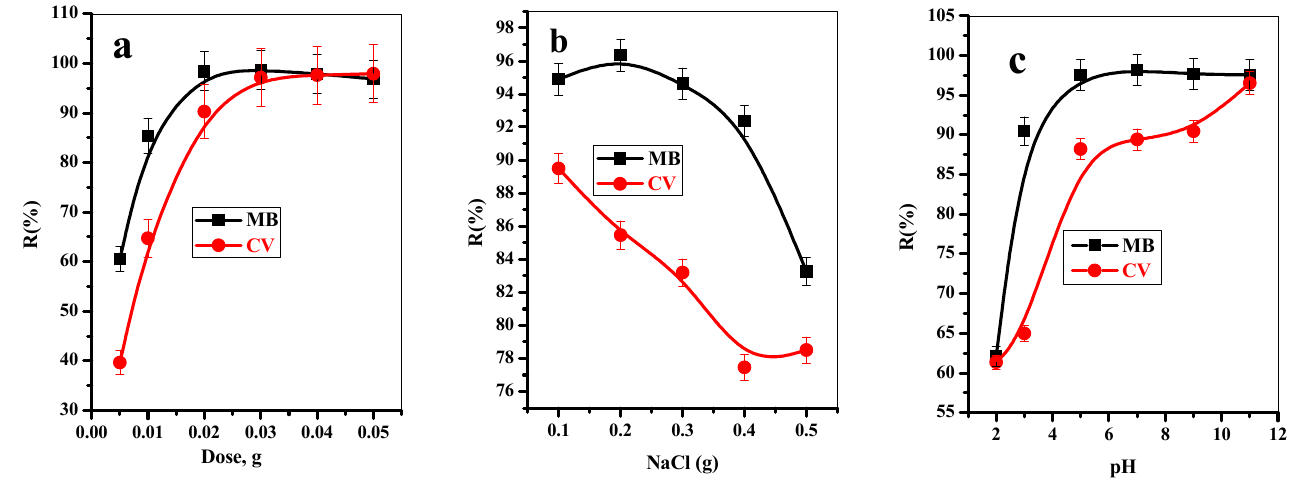
Figure 5. Effect of ( a ) adsorbent dose (t = 8 min for MB and 10 min for CV, [dye] = 30 mg/L, dose = 5, 10, 20, 30, 40, 50 mg, pH = 7, T = 25 ◦ C), ( b ) NaCl dose (t = 8 min for MB and 10 min for CV, (dye) = 30 mg/L, dose = 20 mg, pH = 7, T = 25 ◦ C, NaCL = 100–500 mg), and ( c ) pH on the removal percent of MB and CV-dyes from aqueous solution onto T-BC (t = 8 min for MB and 10 min for CV, (dye) = 30 mg/L, dose = 20 mg, pH = 2–11, T = 25 °C).